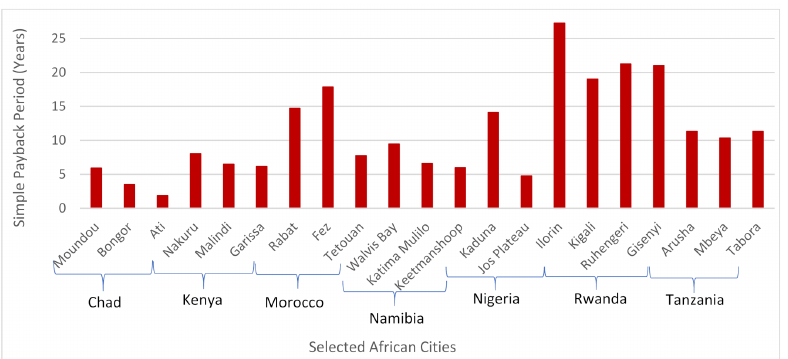
Figure 7. Annualized return on investment and Simple Payback period of the FWT in the selected African cities.